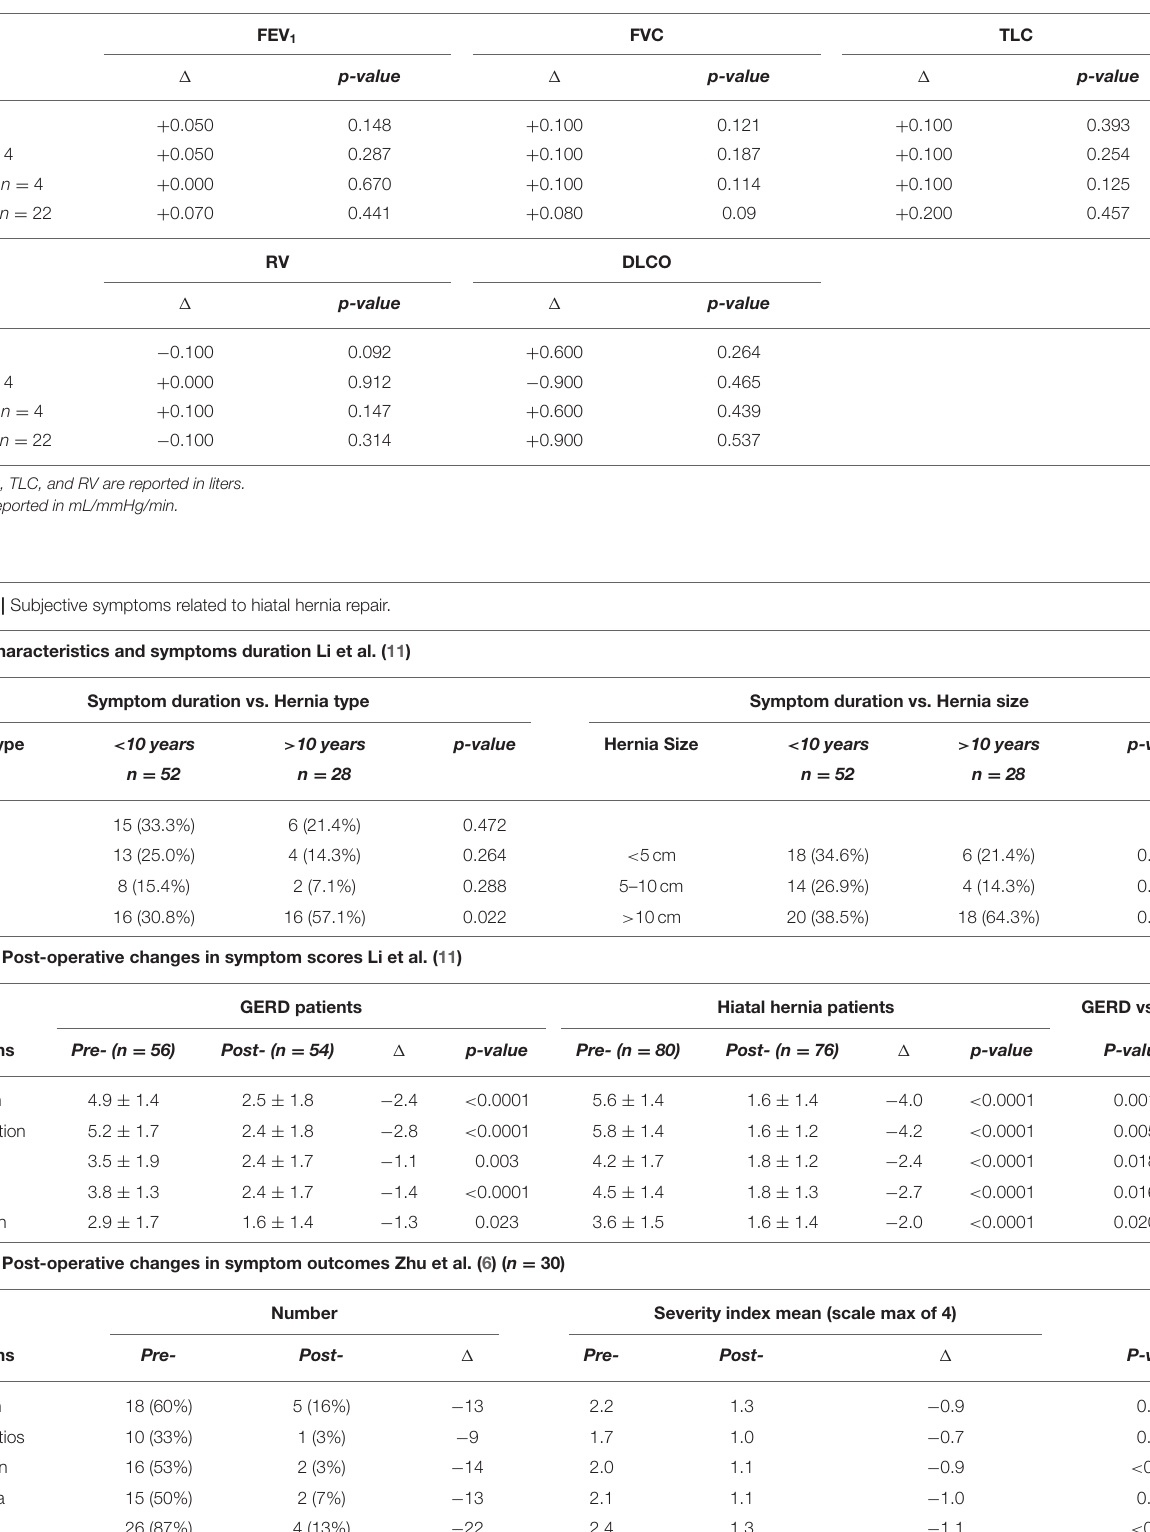
TABLE 4 | Spirometry values stratified by dyspnea Zhu et al. (6).